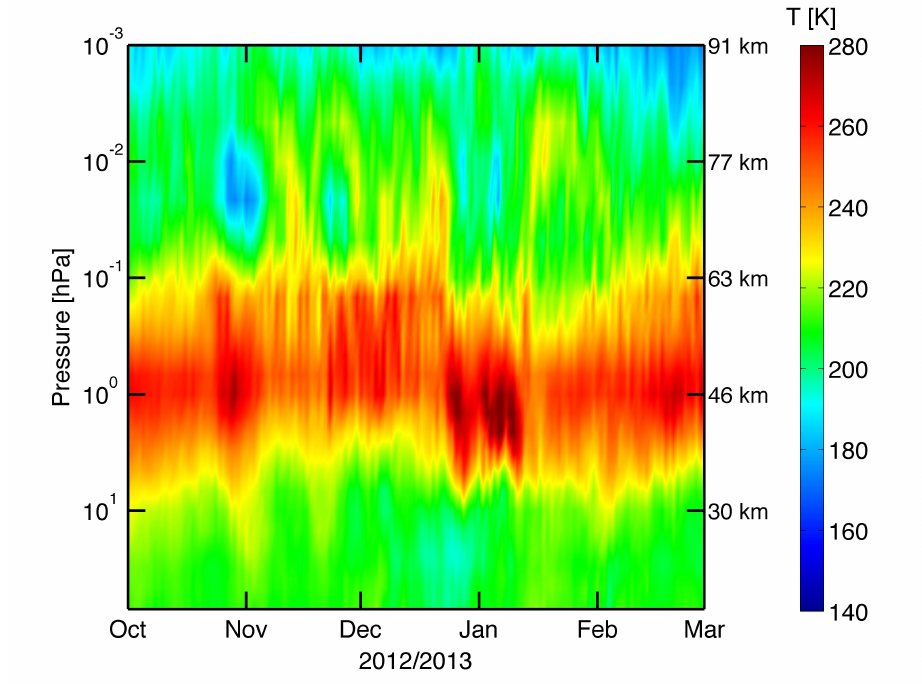
Figure 1. Time series of daily temperature profiles above Bern, Switzerland from 1 October 2012 to 1 March 2013 observed by the Aura Microwave Limb Sounder. Mesospheric inversion layers (temperature enhancements) typically occur at about p = 0.005 hPa in the winter months from November to February. Planetary wave-like oscillations with periods from 10 to 30 days are present in the wintertime stratosphere and mesosphere. Dashed lines show the error of the